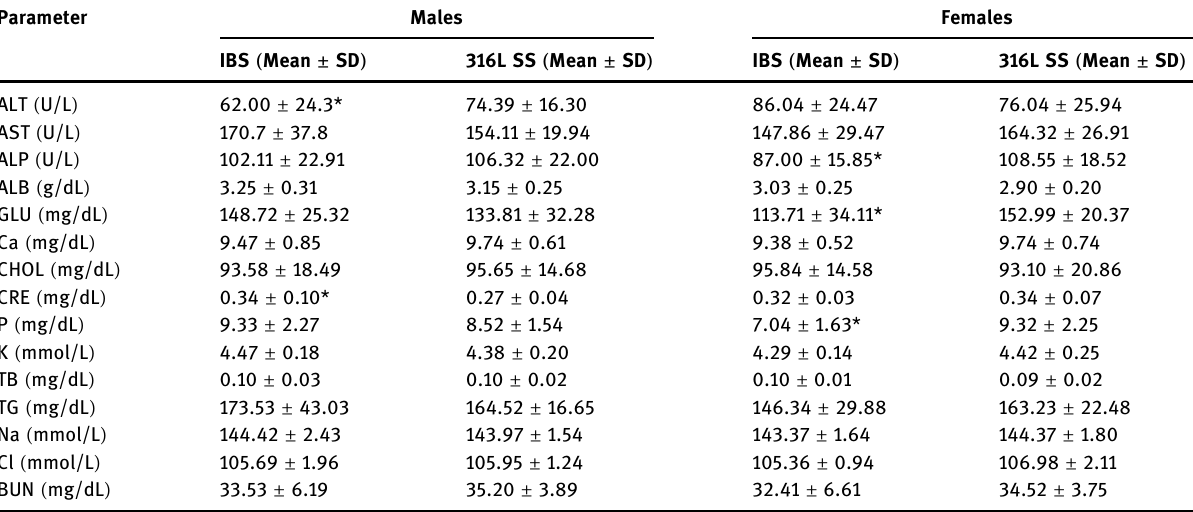
Table 3: Summary of chemical pathology